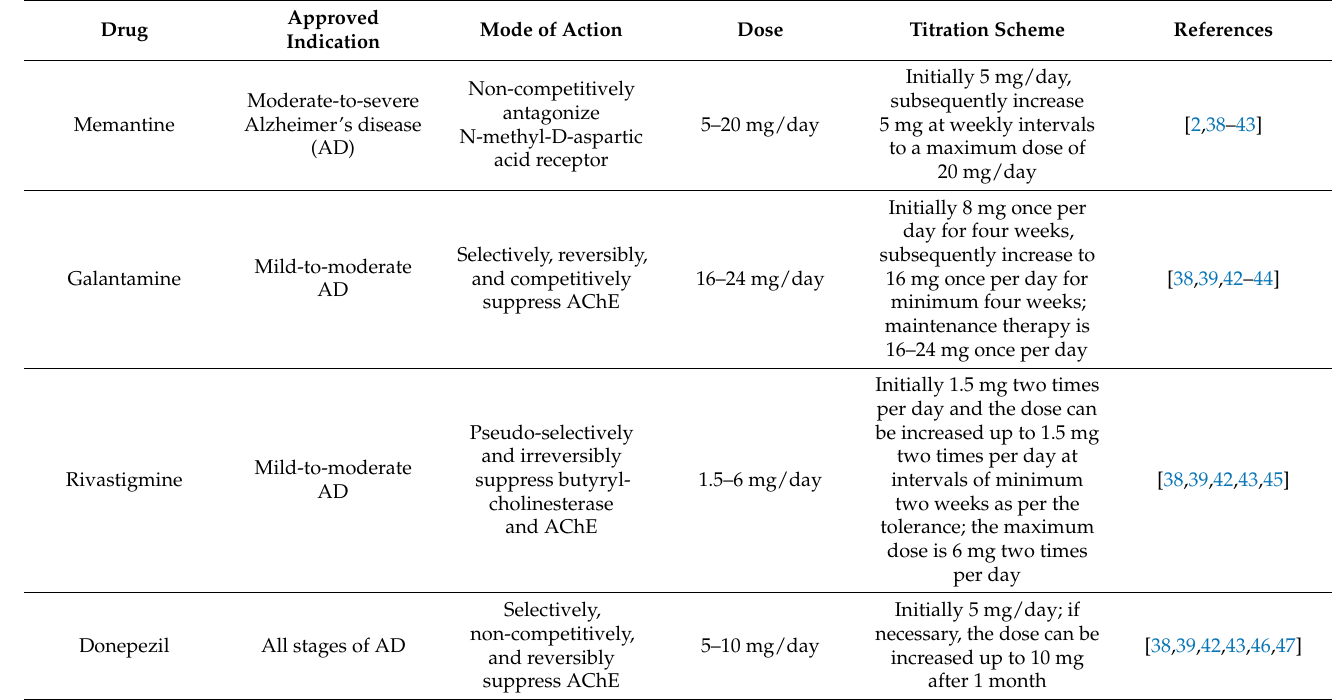
Table 1. Currently available therapies for Alzheimer’s disease